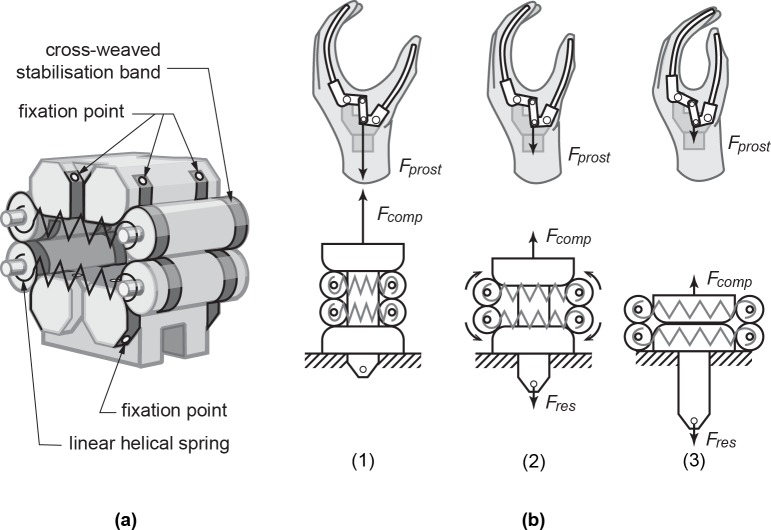
Conceptual design of the Rolling Stiffness Compensation Mechanism (RSCM).(a) Its overall shape and how the parts connect through cross-weaved stabilization bands, indicating the visible fixation points, and (b) its working principle in combination with the WILMER WHD-4 mechanism.